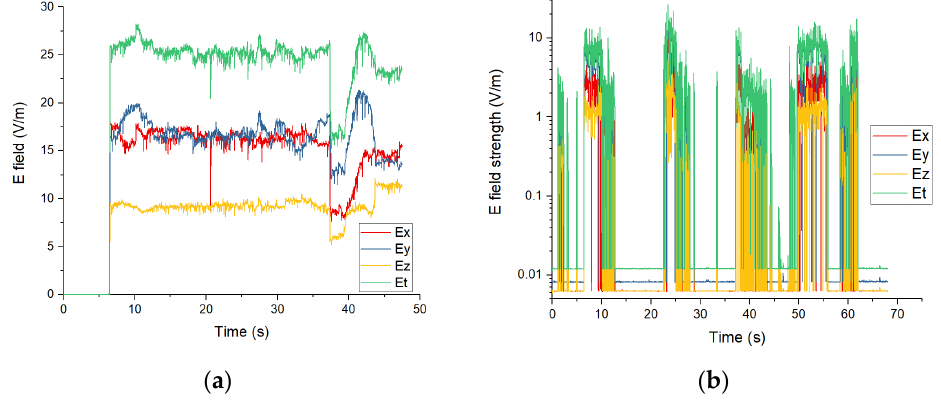
Figure 13. Time evolution of Ex, Ey, Ez, and Etotal for LTE-A speed test ( a ) and streaming ( b ).